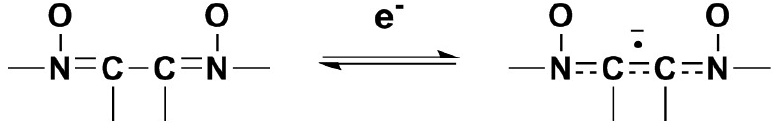
Figure 3. One electron reduction of the di- N -oxide structure to a radical anion.